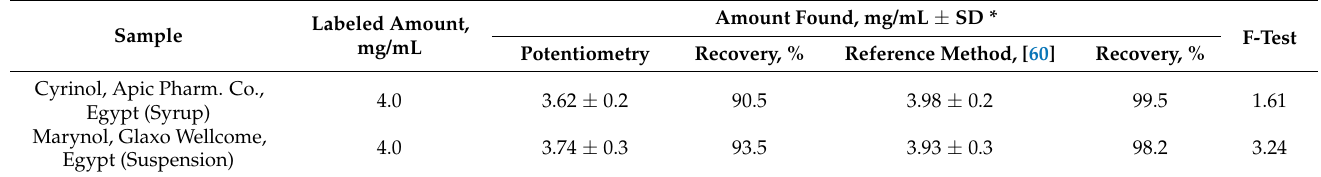
Table 3. Determination of PHL in different pharmaceutical formulation